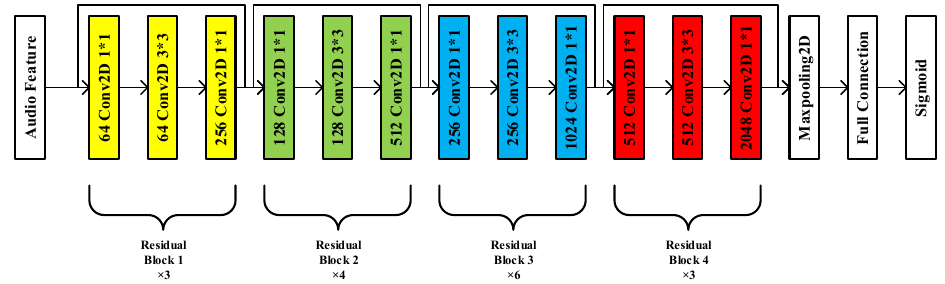
Figure 13. The structure of ResNet-50 neural network.